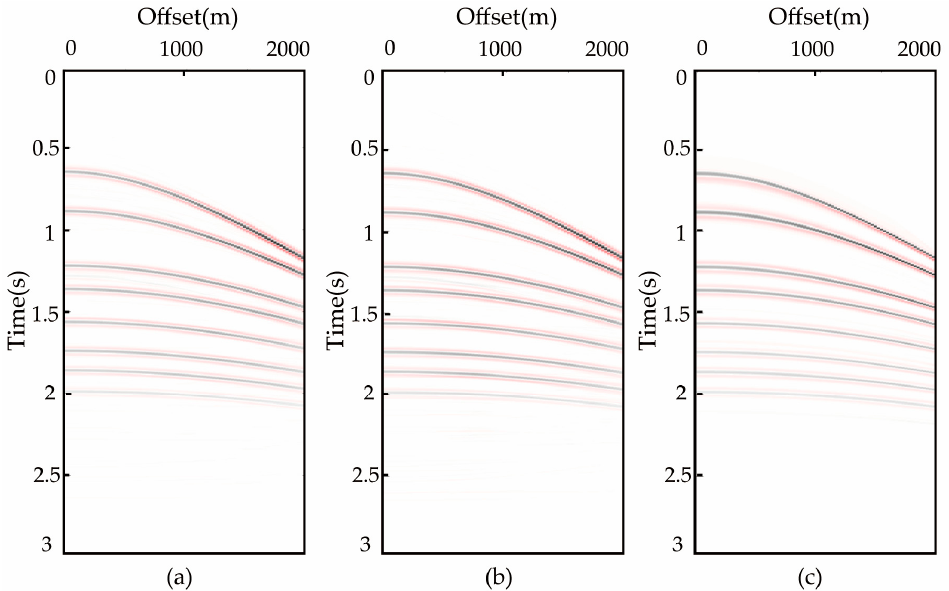
Figure 7. Multiple attenuation results of missing trace data by SPRT L q 1 − L q 2 : ( a ) 30% missing traces; ( b ) 50% missing traces; ( c ) 70% missing traces.